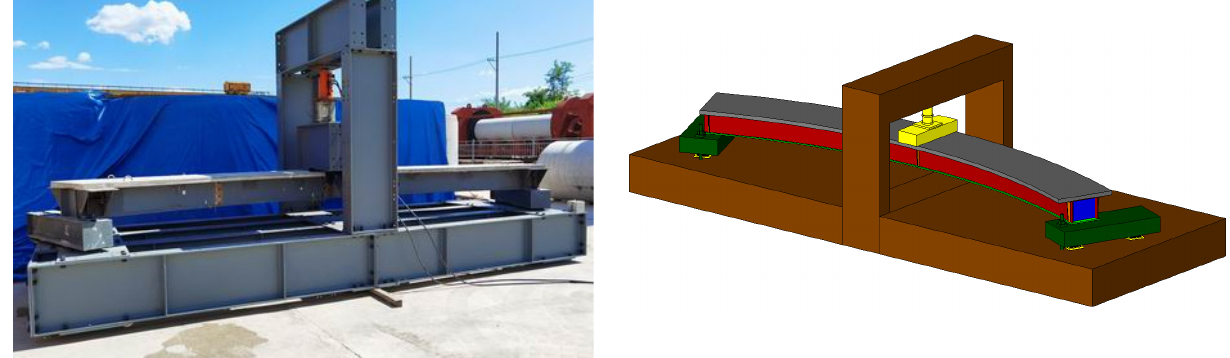
Figure 4. Photos and schematic plot of